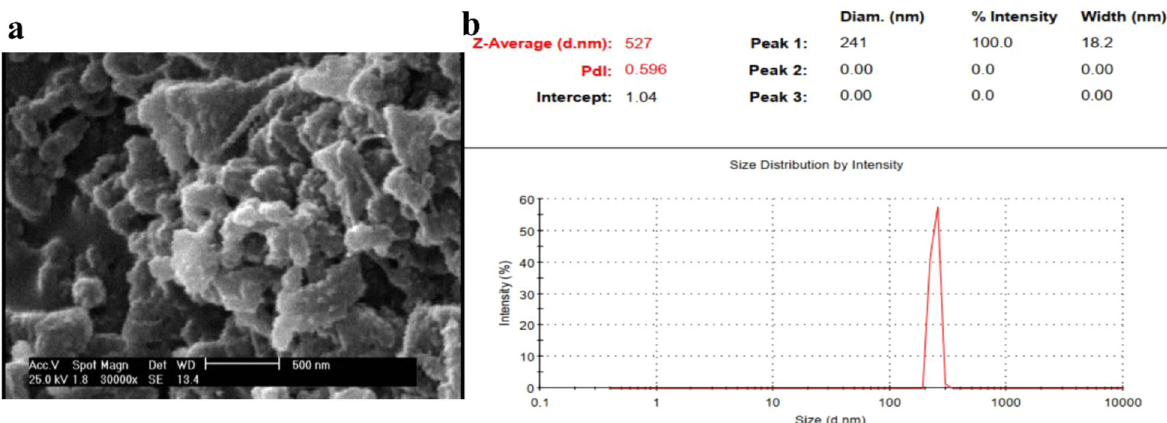
Fig. 1 SEM morphology by the magni fi cation of ×30,000 approves the diameter of the nanoparticles as 212 ± 31 nm ( a ). DLS study of the curcumin niosome nanoparticles after washing, ultrasonic sonication and dilution steps reports the resultant diameter as 241 nm with PDI of 0.596